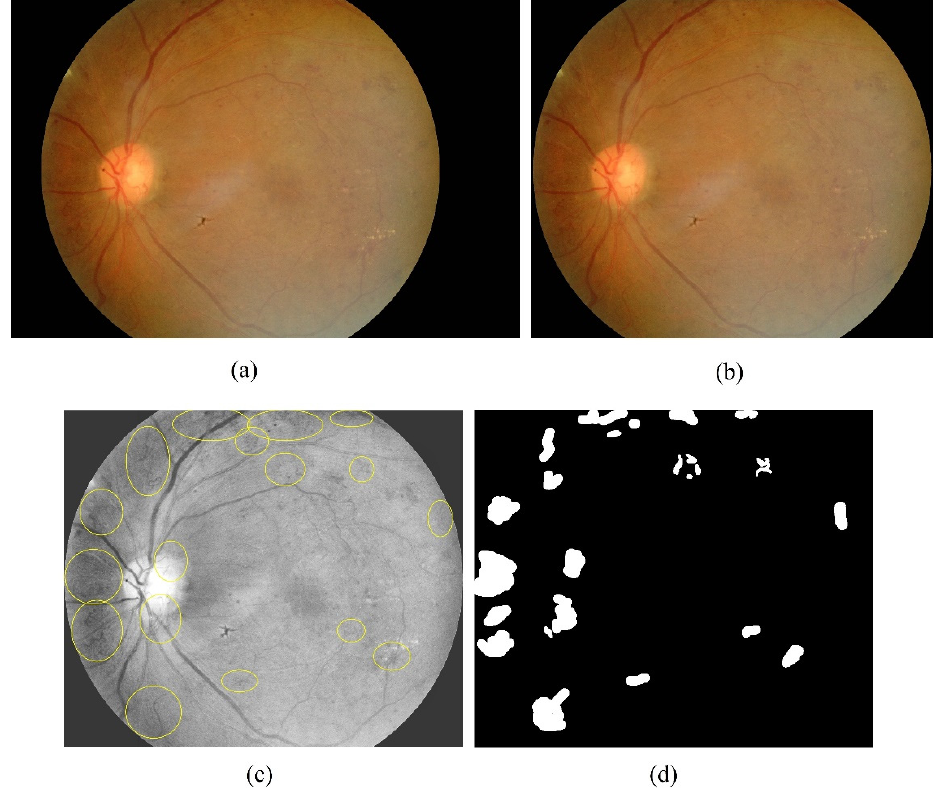
Figure 2. The process of ground truth generation. ( a ) original fundus image; ( b ) cropped image ( c ) labeled image by an ophthalmologist after green channel extraction and contrast enhancement; ( d ) ground truth image.